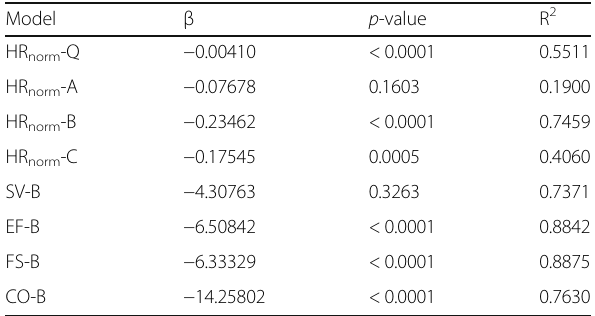
Table 2 Regression coefficients and goodness of fit values for potential predictors of various measures of heart activity